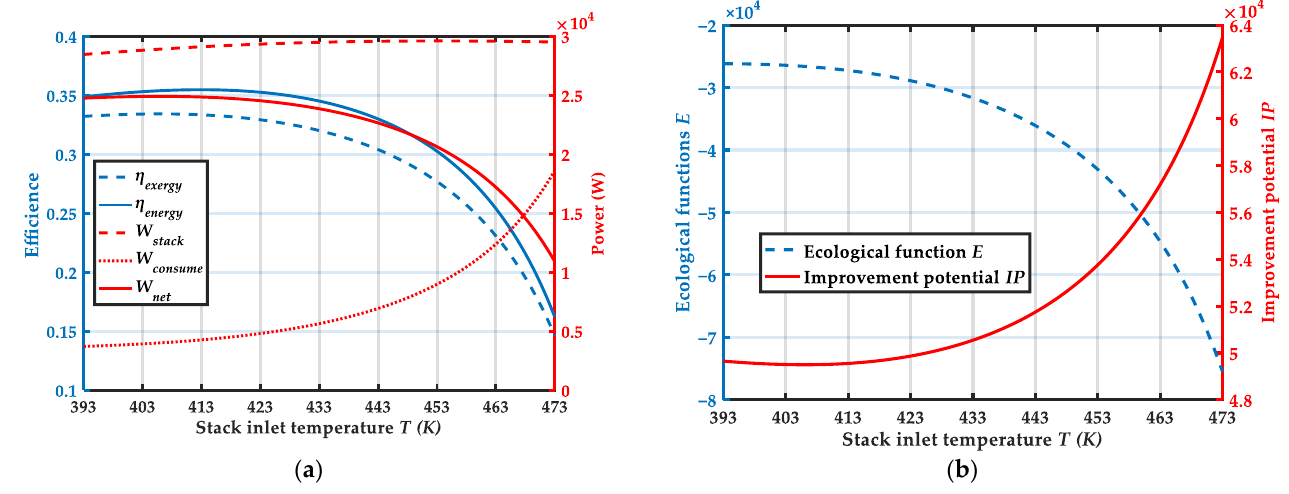
Figure 6. Variation trends of system performance with stack inlet temperature 𝑇 : ( a ) Variation trends of 𝜂 𝑒𝑛𝑒𝑟𝑔𝑦 , 𝜂 𝑒𝑥𝑒𝑟𝑔𝑦 , 𝑊 𝑠𝑡𝑎𝑐𝑘 , 𝑊 𝑐𝑜𝑚𝑠𝑢𝑚𝑒 and 𝑊 𝑛𝑒𝑡 with stack inlet temperature 𝑇 ; ( b ) Variation of ecological function 𝐸 and improvement potential 𝐼𝑃 with stack inlet temperature 𝑇 .